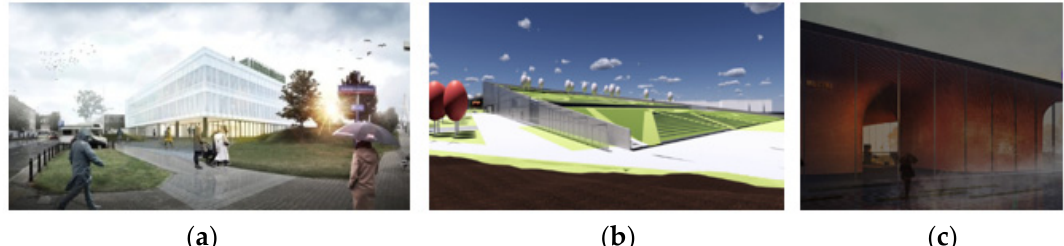
Figure 1. Conceptual designs of ( a ) the Copernican Revolution Studio; ( b ) the Cogiteon Lesser Poland Science Center; ( c ) the Krakow Music Center. Sources: ( a ) [44]; ( b ) [45]; ( c ) [46].